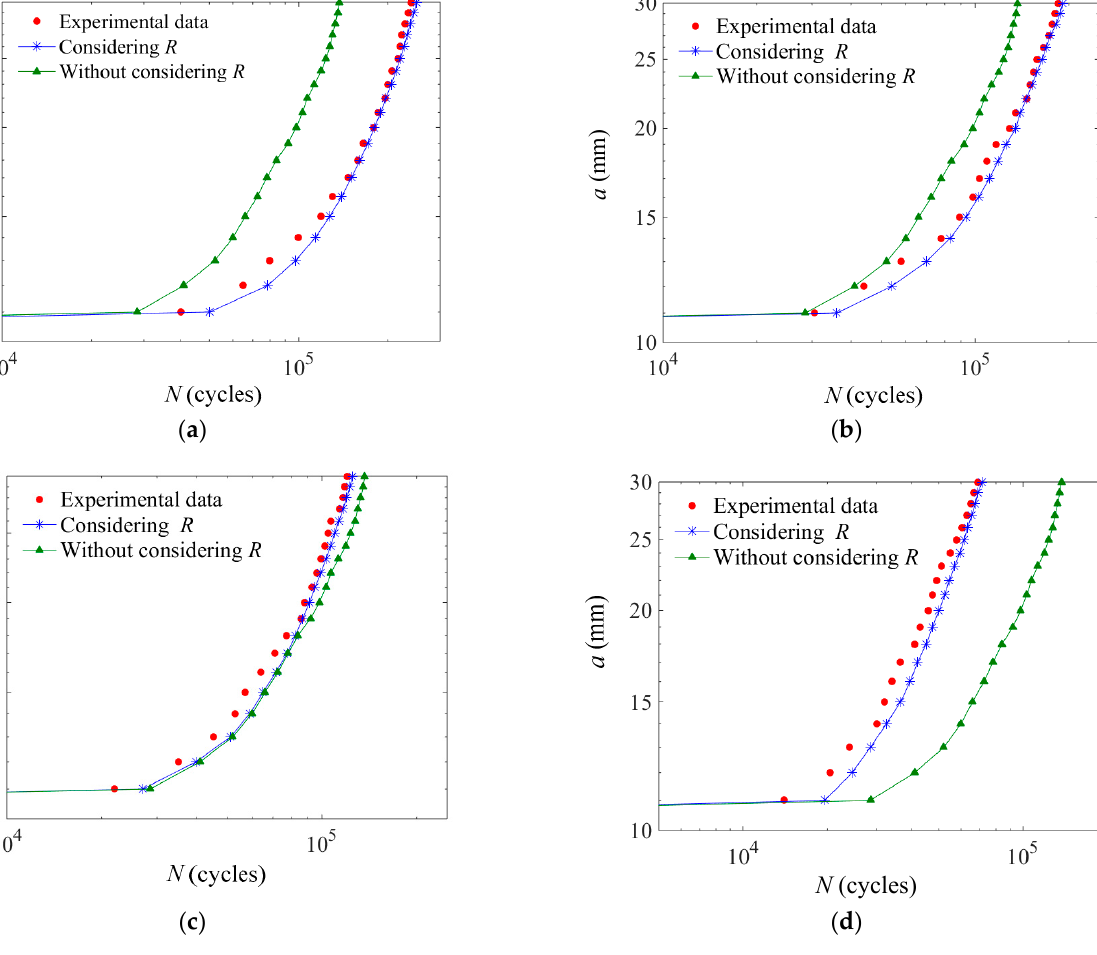
Figure 12. Comparison of experimental and simulation results under different stress ratios. ( a ) R = 0.1; ( b ) R = 0.3; ( c ) R = 0.5; ( d ) R = 0.7.